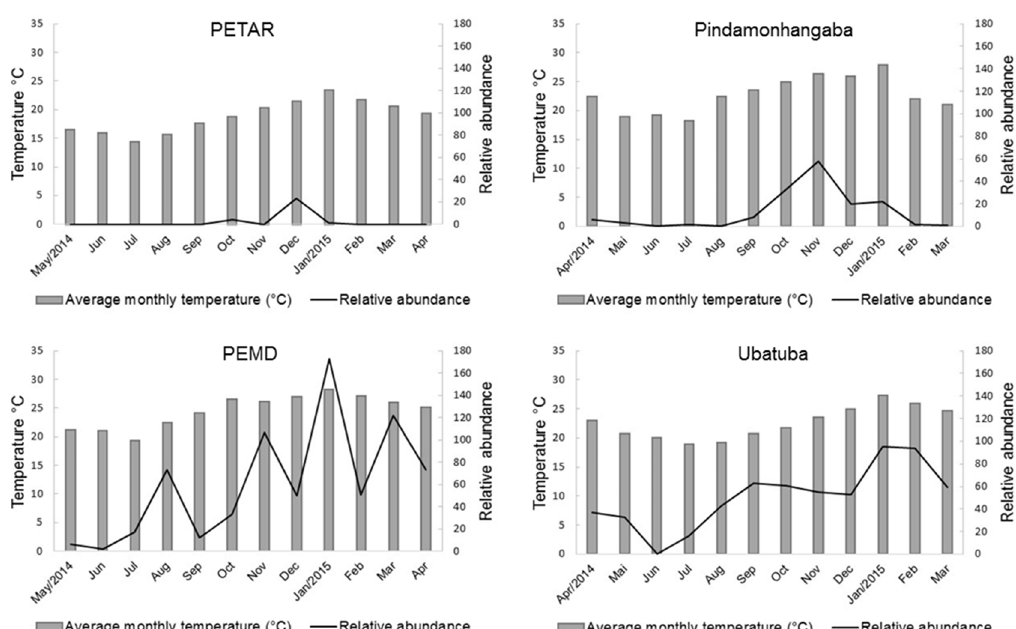
Fig 1 . Monthly fluctuation of the abundance of bees and species richness of the Euglossini tribe as a function of temperature (in degrees Celsius) in areas with different forest vegetation types in São Paulo State, Brazil: (A) PETAR: Parque Estadual Turístico do Alto Ribeira ; (B) Pindamonhangaba; (C) PEMD: Parque Estadual Morro do Diabo and (D)